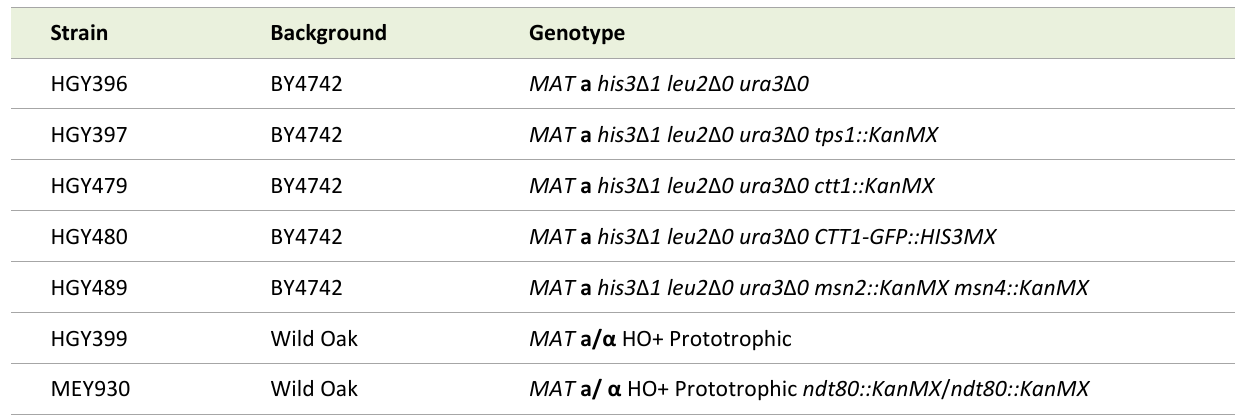
Trehalose extraction and measurement